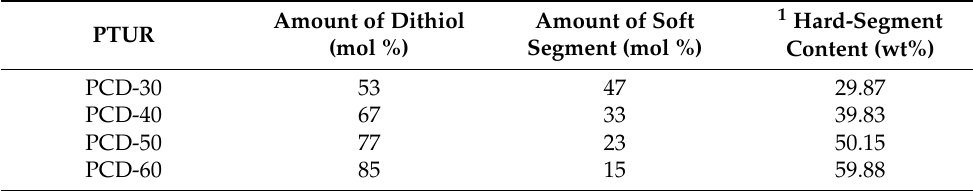
Figure 2. ( a ). Chemical structures of the reactants; ( b ) Schematic representation of the synthesis route of polymers; ( c ) Images of the synthesized polymers. Designations and composition used to synthesize the PTURs are given in Table 1. The polymers were designated as X-Y, where X is the abbreviation of soft segment and Y represents the hard-segment content. Table 1. Designations of the PTURs.